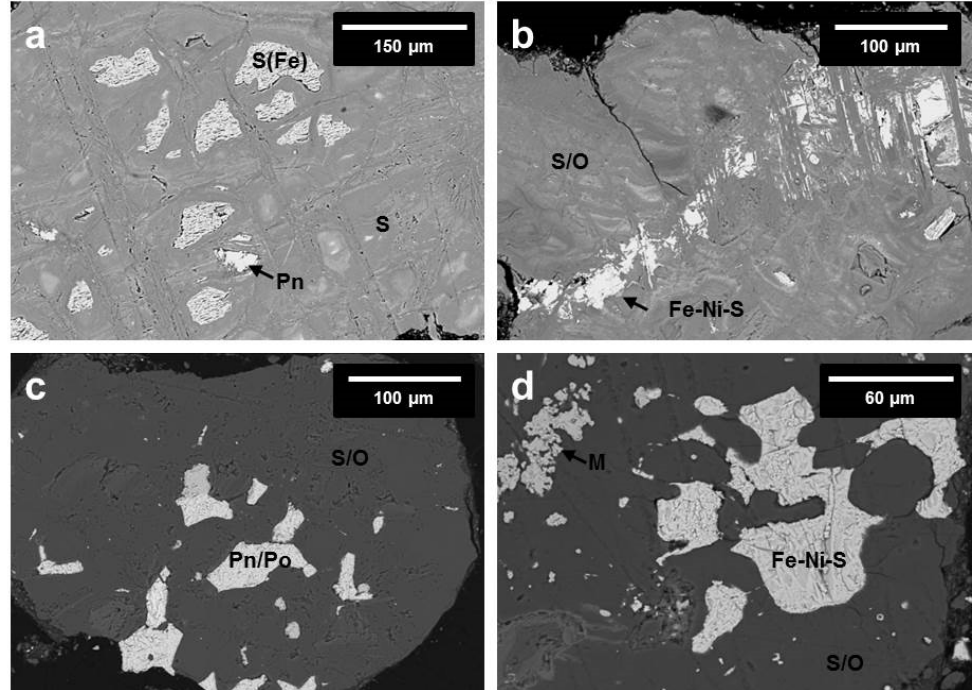
Figure 7. SEM-BSE images of ( a ) untreated OK ore, ( b ) OK ore microwave pretreated for 15 min, ( c ) untreated Pipe ore, and ( d ) Pipe ore microwave pretreated for 8 min. The phases are designated as follows: serpentine (S), iron-substituted serpentine (S(Fe)), olivine (F), pentlandite (Pn), pyrrhotite (Po), iron-nickel sulphide (Fe-Ni-S), and magnetite (M).